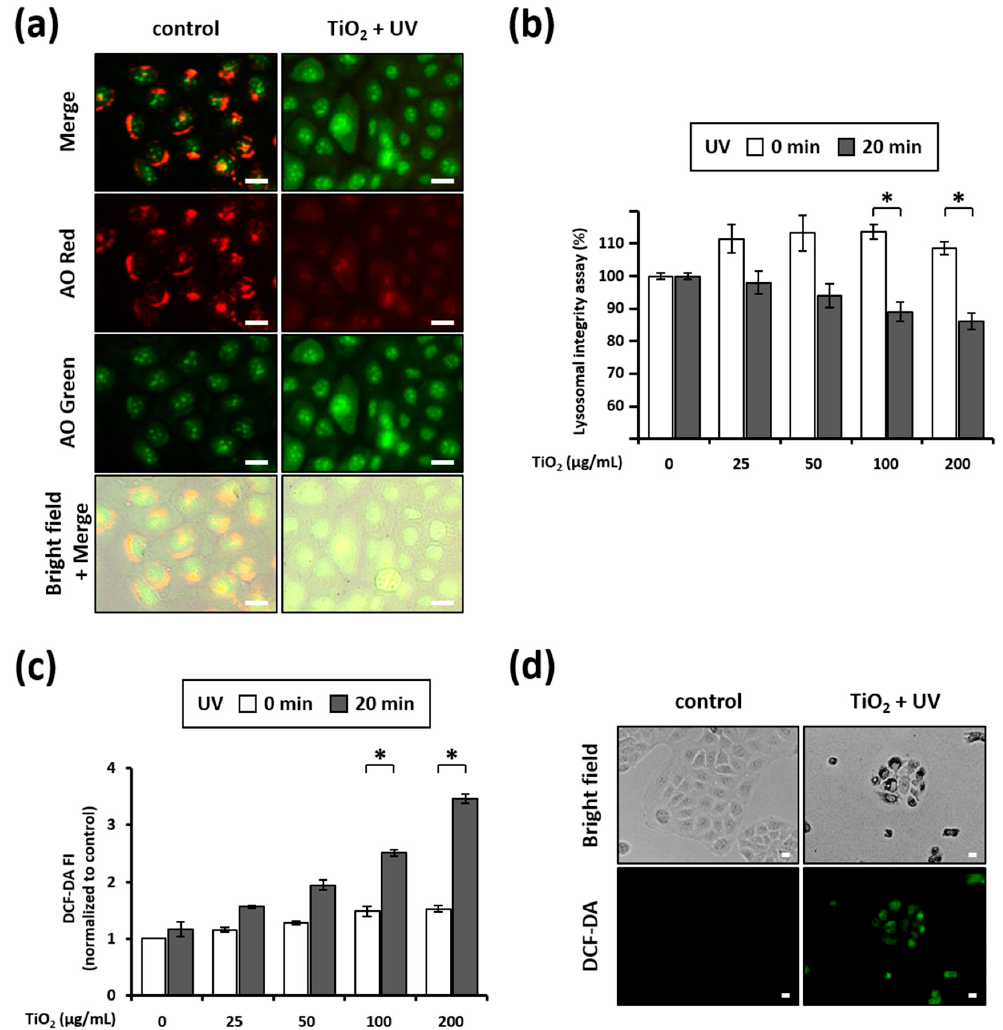
Figure 6. LMP induction and ROS generation by the combination of TiO 2 NPs and UVA: ( a ) the treated cells were stained with AO and then observed by fluorescence microscopy. Scale bars correspond to 10 µ m; ( b ) after AO staining, the cells were treated with TiO 2 NPs and UVA for 8 h. The cells were subjected to microplate reading. Data are presented as mean ± SD ( n = 8). * p < 0.05, compared with dark conditions; ( c,d ) the treated cells were stained with CM-H 2 DCF-DA. The cells were subjected to microplate reading: ( c ) data are presented as mean ± SD ( n = 6). * p < 0.05, compared with dark conditions; ( d ) cells were observed by fluorescence microscopy. Scale bars correspond to 20 μ m.